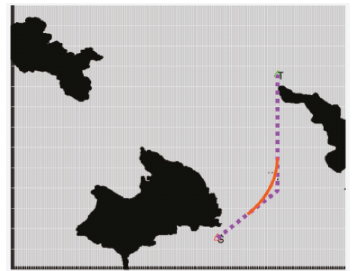
Figure 21: Smoothing optimization results of the algorithm in this paper.